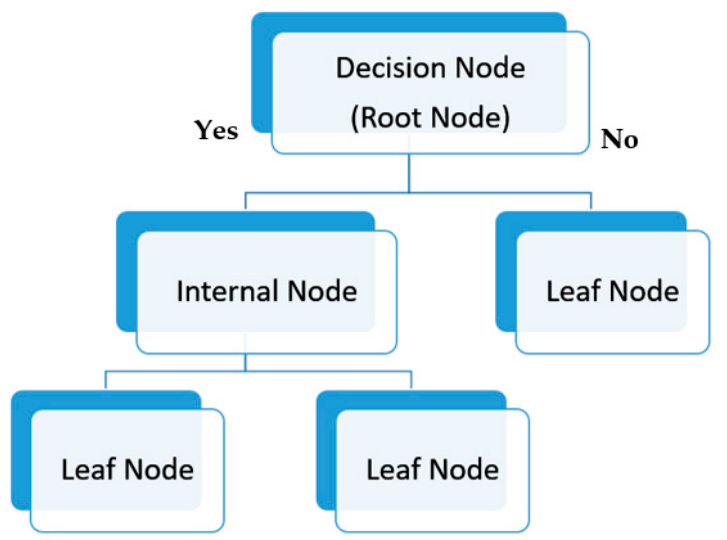
Figure 8. Illustrated example of binary decision tree.